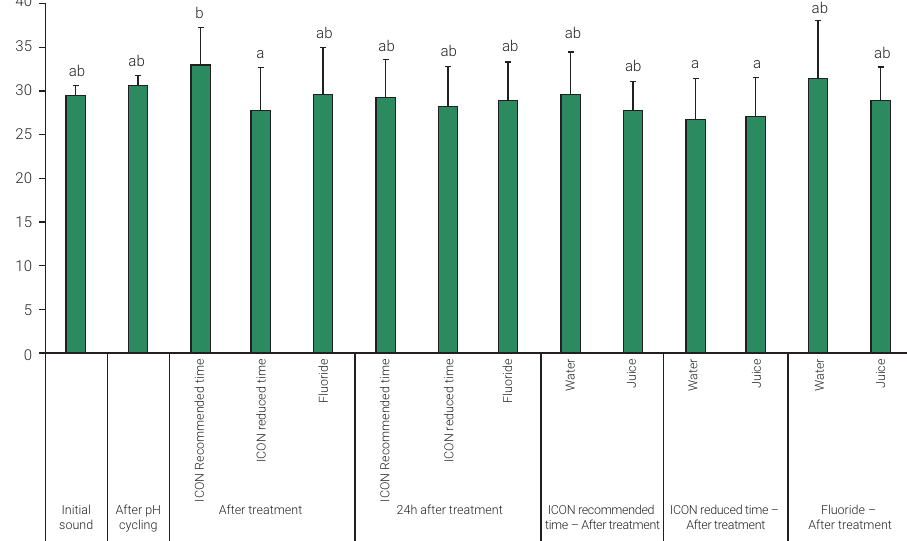
ICON recommended time – After treatment